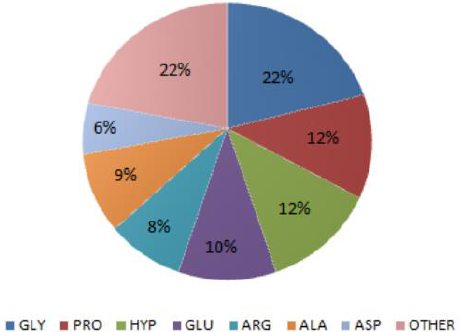
Figure 1. Average amino acid composition of gelatin (GLY—glycine, PRO—proline, HYP—hydroxyproline, GLU—glutamine, ARG—arginine, ALA—alanine, ASP—asparagine) (see website https://en.wikipedia.org/wiki/Gelatin) (Accessed on 10 December 2022).